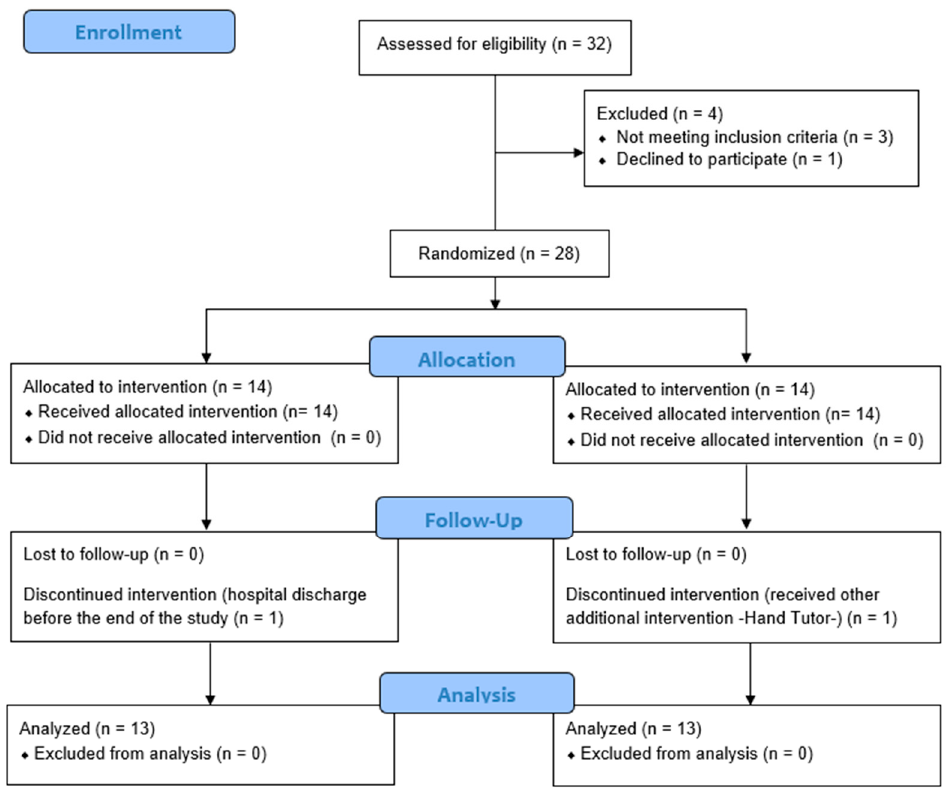
Figure 1. CONSORT flow chart.